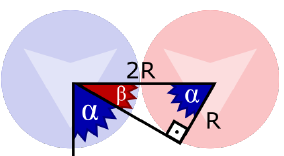
Figure 6. In an extreme situation, where agents are side by side and their radius are equals to R , 2 α should be the lowest horizontal field of view angle so that an agent can see the other by its side.